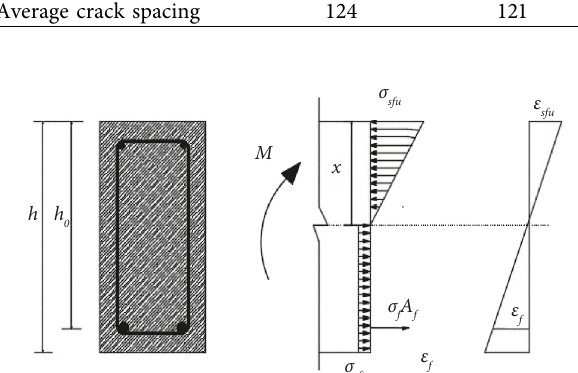
Figure 12: Stress-strain of full-section steel fiber test beam under normal service condition.